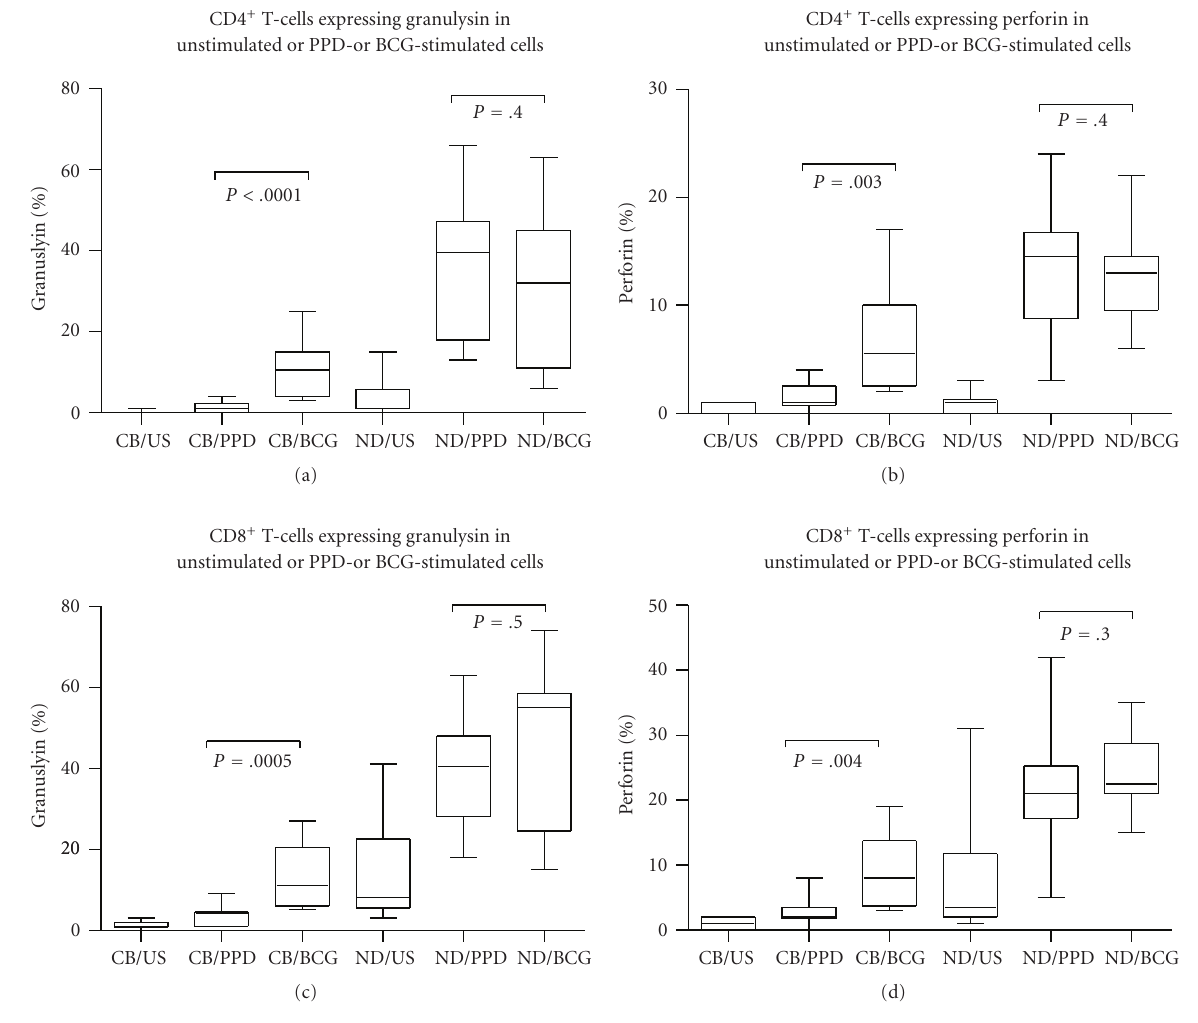
Figure 4: Percentage CD4 + 3 + , CD8 + 3 + expressing Granulysin (a,c), or Perforin (b, d) in unstimulated (US) or PPD- or BCG-stimulated cord blood mononuclear cells (CB n = 10) or peripheral blood mononuclear cells from healthy PPD + adult volunteers (ND n = 10). Significance is shown between PPD and BCG stimulation in CB and adult volunteers. The box extends from the 25th to 75th percentile, the line represents the median, and the whiskers represent the maximum and minimum